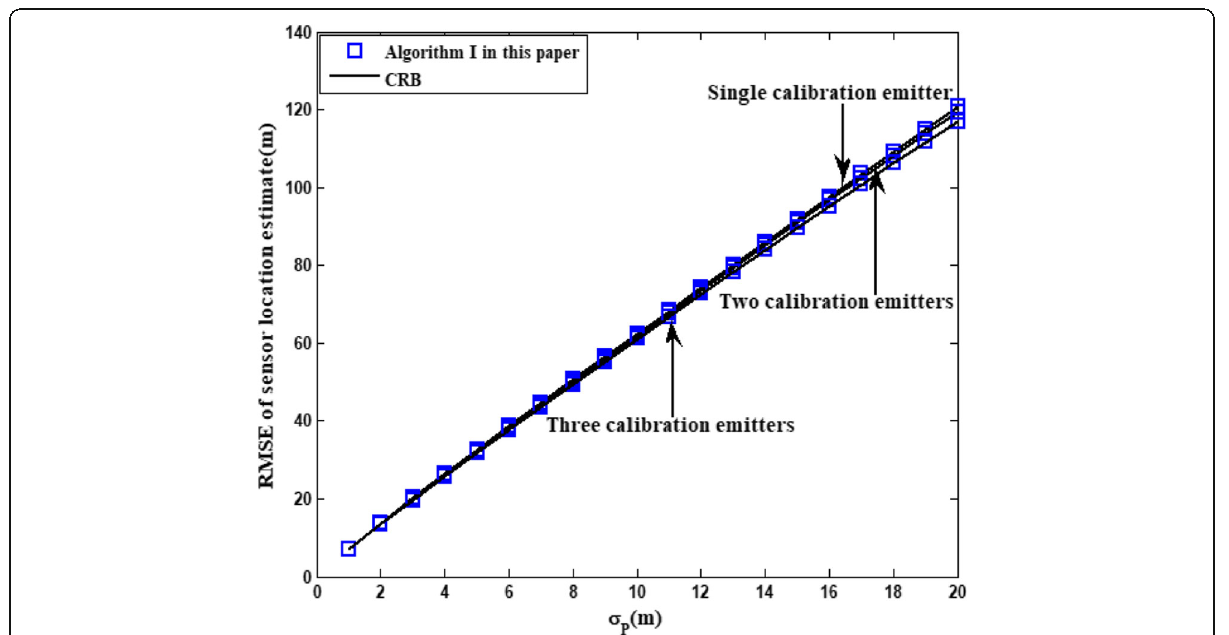
Fig. 19 RMSE of sensor location estimate versus σ P for a different number of calibration